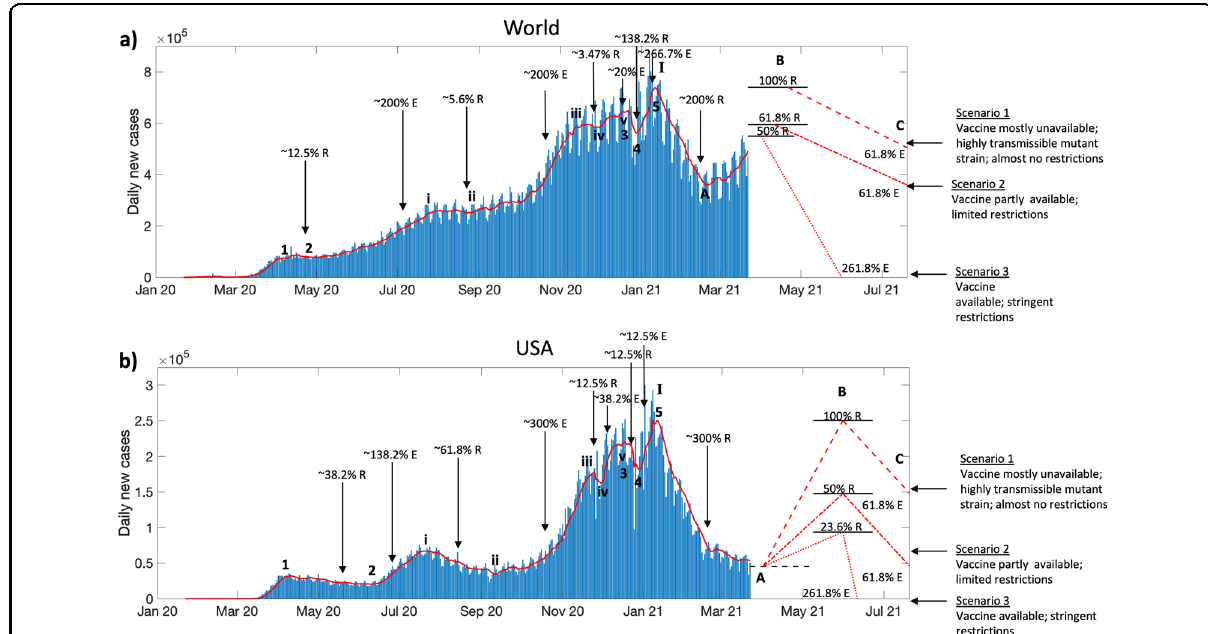
Fig. 3 Predictions based on the Wave Principle. Elliott wave analysis for the ( a ) world and ( b ) USA using the Fibonacci Pinball method. Dotted, dashed-dotted, and dashed red lines show predictions of best-, intermediate-, and worst-case scenarios, respectively, for daily new infections. Black arrows point out the closest Fibonacci ratio exhibited by an extension (E) or a retracement (R) of the wave. Horizonal black solid and dashed lines represent the resistance and support levels, respectively, for daily new cases based on the most common Fibonacci